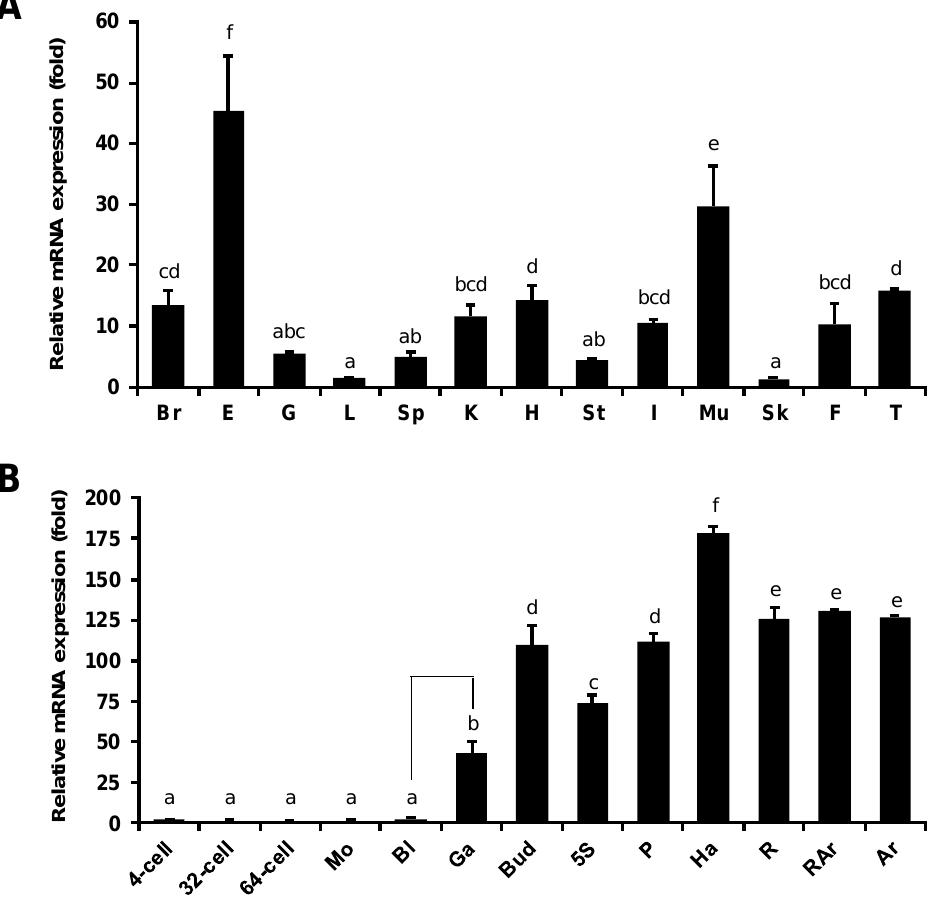
Figure 4. Tissue distribution and developmental expression of PoMaf1 in P. olivaceus . ( A ) Tissue distribution of PoMaf1 mRNA in P. olivaceus . The PoMaf1 mRNA level was measured by quantitative real-time PCR. Values were normalized to that of 18S rRNA and are shown as fold relative values compared to skin. Br, brain; E, eye; G, gill; L, liver; Sp, spleen; K, kidney; H, heart; St, stomach; I, intestine; Mu, muscle; Sk, skin; F, fin; T, testis. ( B ) PoMaf1 mRNA level during early development of P. olivaceus . Embryo and larvae samples were harvested from the four-cell stage to 27 days post-hatching (dph). mRNA levels were normalized to that of 18S rRNA and 64-cell-stage values were compared to those at other stages. 4-cell, 4-cell stage; 32-cell, 32-cell stage; 64-cell, 64-cell stage; Mo, morula stage; Bl, blastula stage; Ga, gastrula stage; Bud, bud stage; 5S, 5-somite stage; P, pharyngula stage; Ha, hatched larva (0 dph); R, rotifer feeding stage (12 dph); RAr, rotifer and Artemia feeding stage (20 dph); Ar, Artemia feeding stage (27 dph). Means and standard deviations of three independent replicates are shown. Means with the same superscript letter are not significantly different ( p ≤ 0.05).